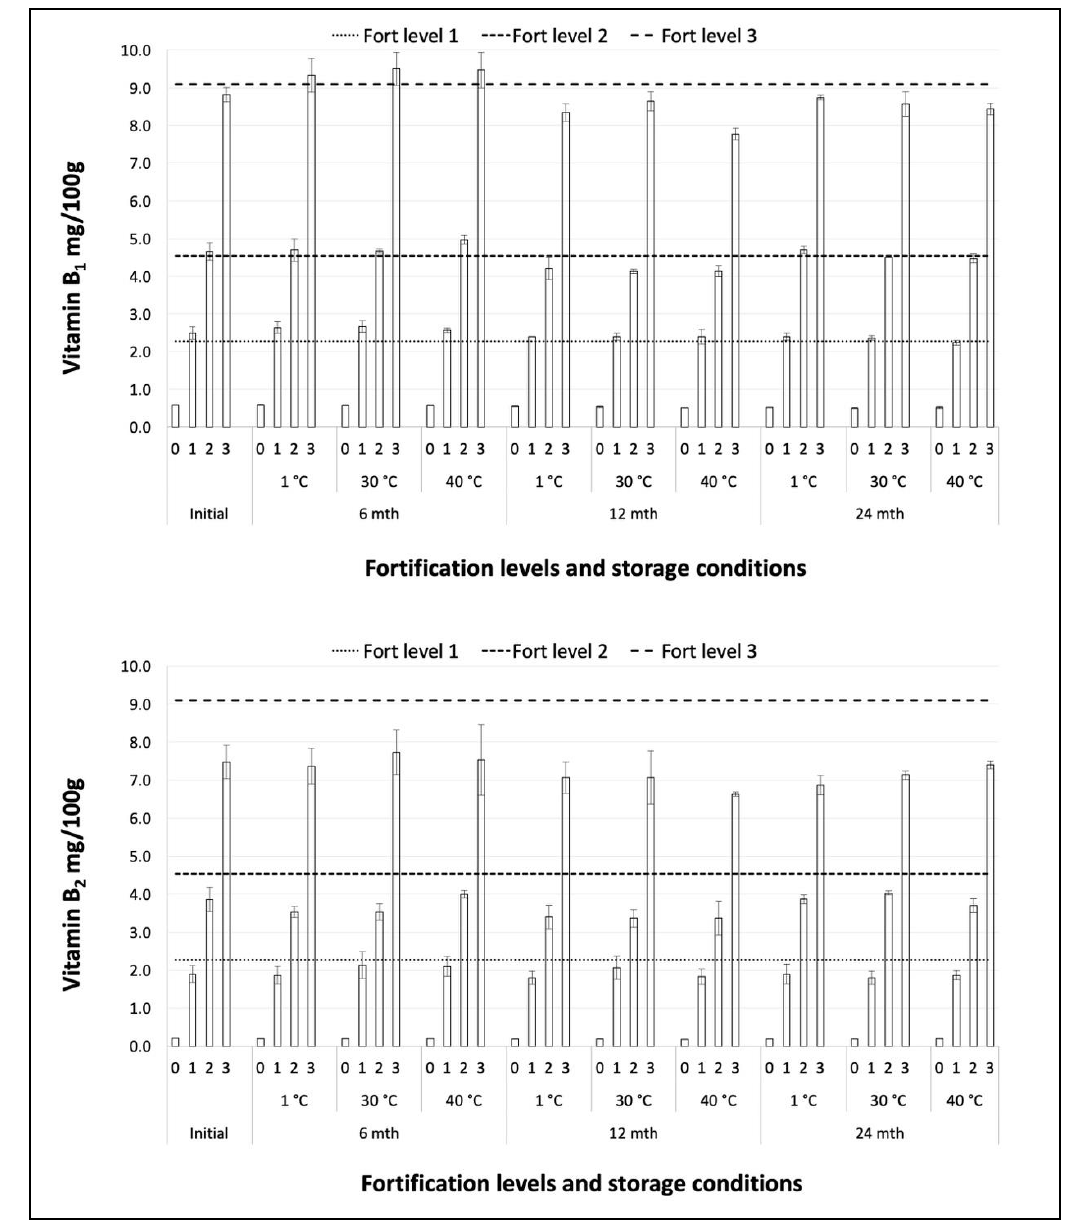
Figure 1. Vitamins B 1 and B 2 storage stability at all levels of fortification (0, 1, 2, 3).